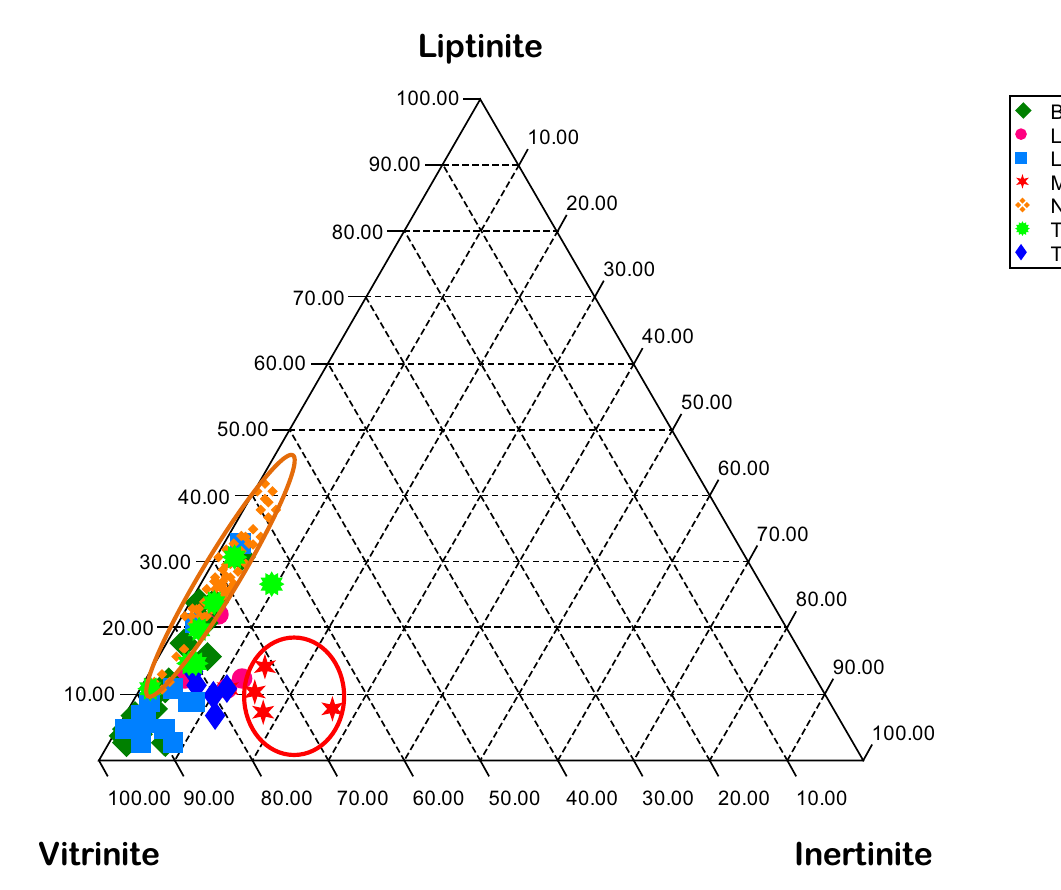
Fig. 9 Ternary Plot showing the maceral types in candidate source rocks ( n = 70) of the onshore Sarawak. Sample points are colour coded based on geologic formation: LBF Lambir, MRF Miri, TKF Tukau, TJF Tanjong, NYF Nyalau, BLG Balingian and LNG Liang